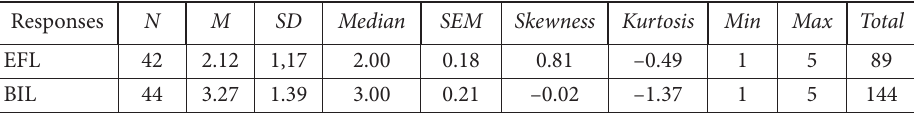
Table 2. Descriptive statistics of the scale items B – achieved objectives stated in the plan for English as foreign language (EFL) and bilingual (BIL) groups (source: created by authors) Responses